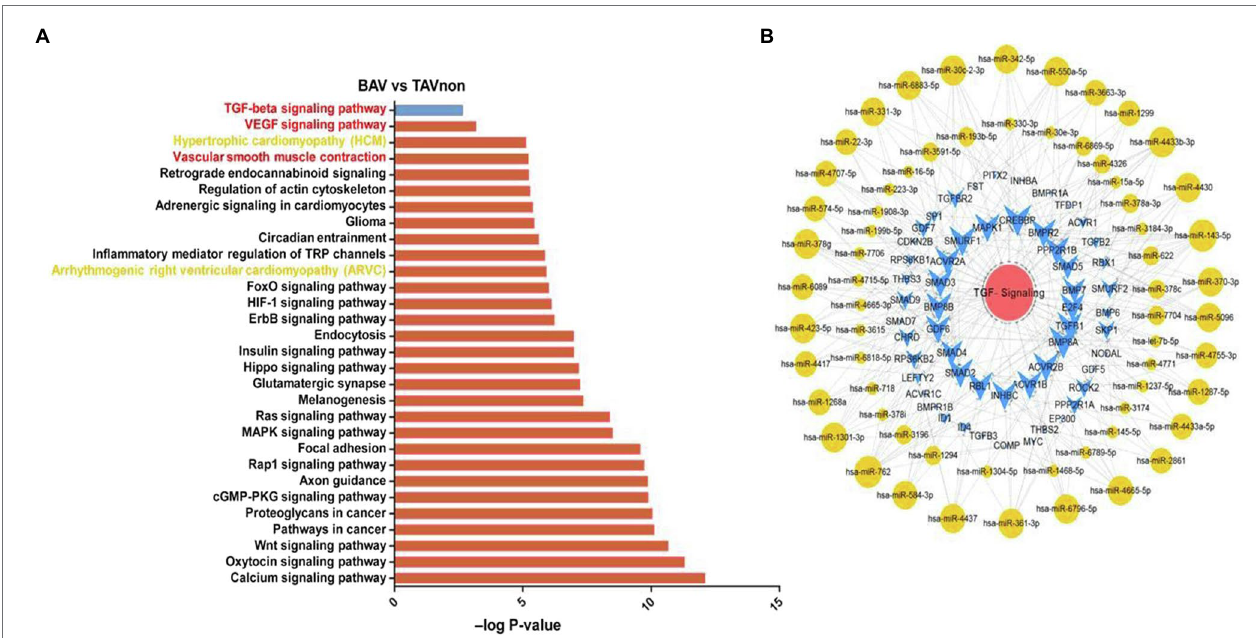
FIGURE 4 | miRNA target gene function analysis and integrated miRNA/mRNA/TGF- β signaling network construction. (A) Pathway enrichment analysis highlighted the pathways of intracellular signal transduction deduced by the predicted target genes of DE miRNAs between BAV and TAVnon groups. (B) Interaction network of miRNAs and target genes involved in TGF- β signaling